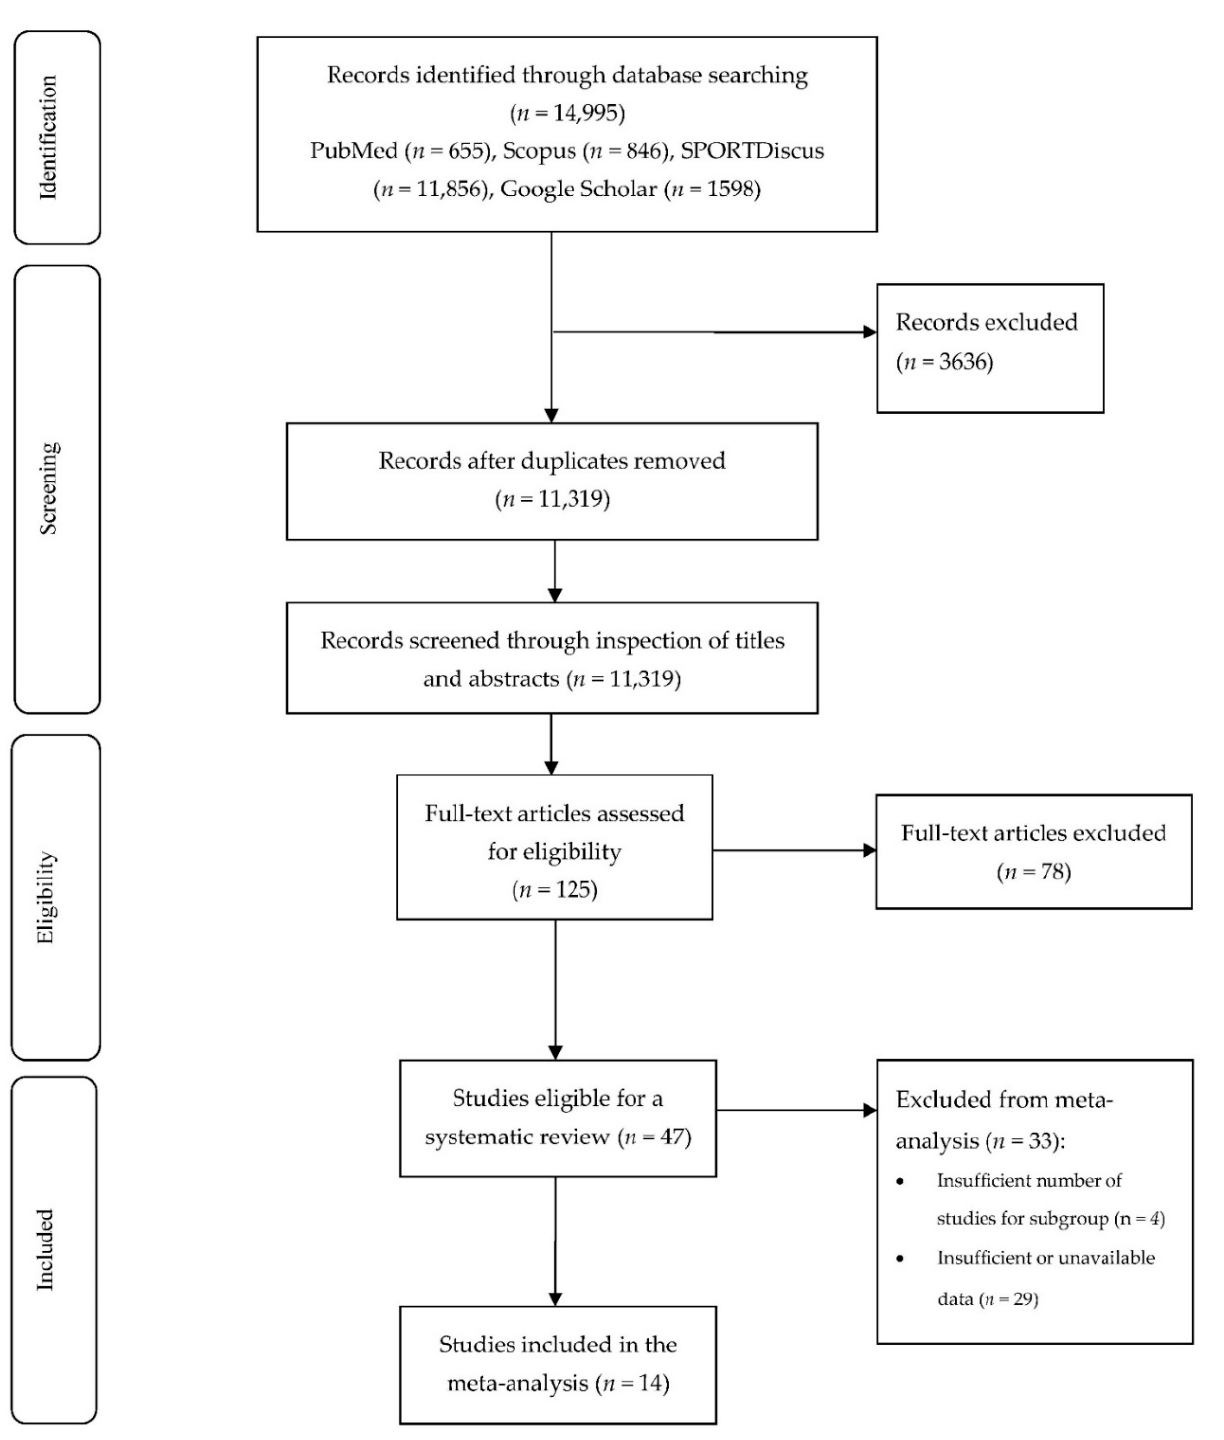
Figure 1. Flowchart of the meta-analysis search process.